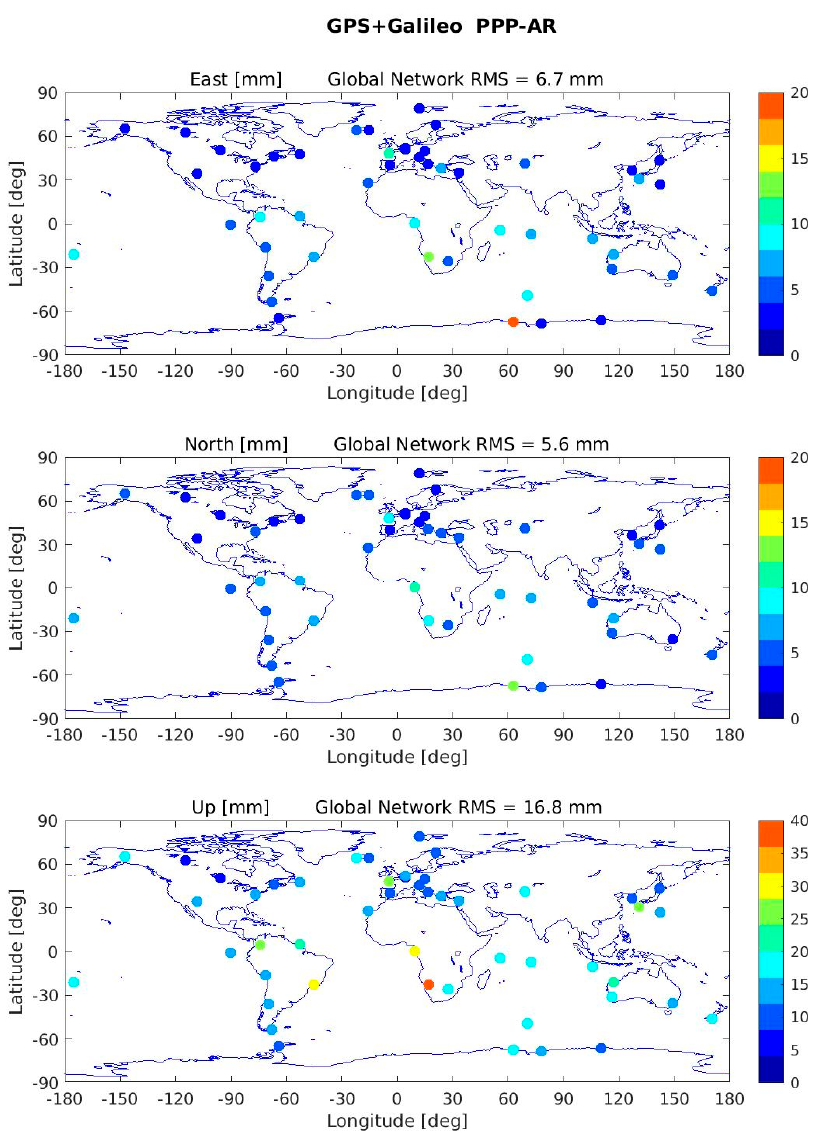
Figure 4. GPS + Galileo PPP-AR solutions for the network of IGS stations in East, North and Up components and their global RMS (mm).